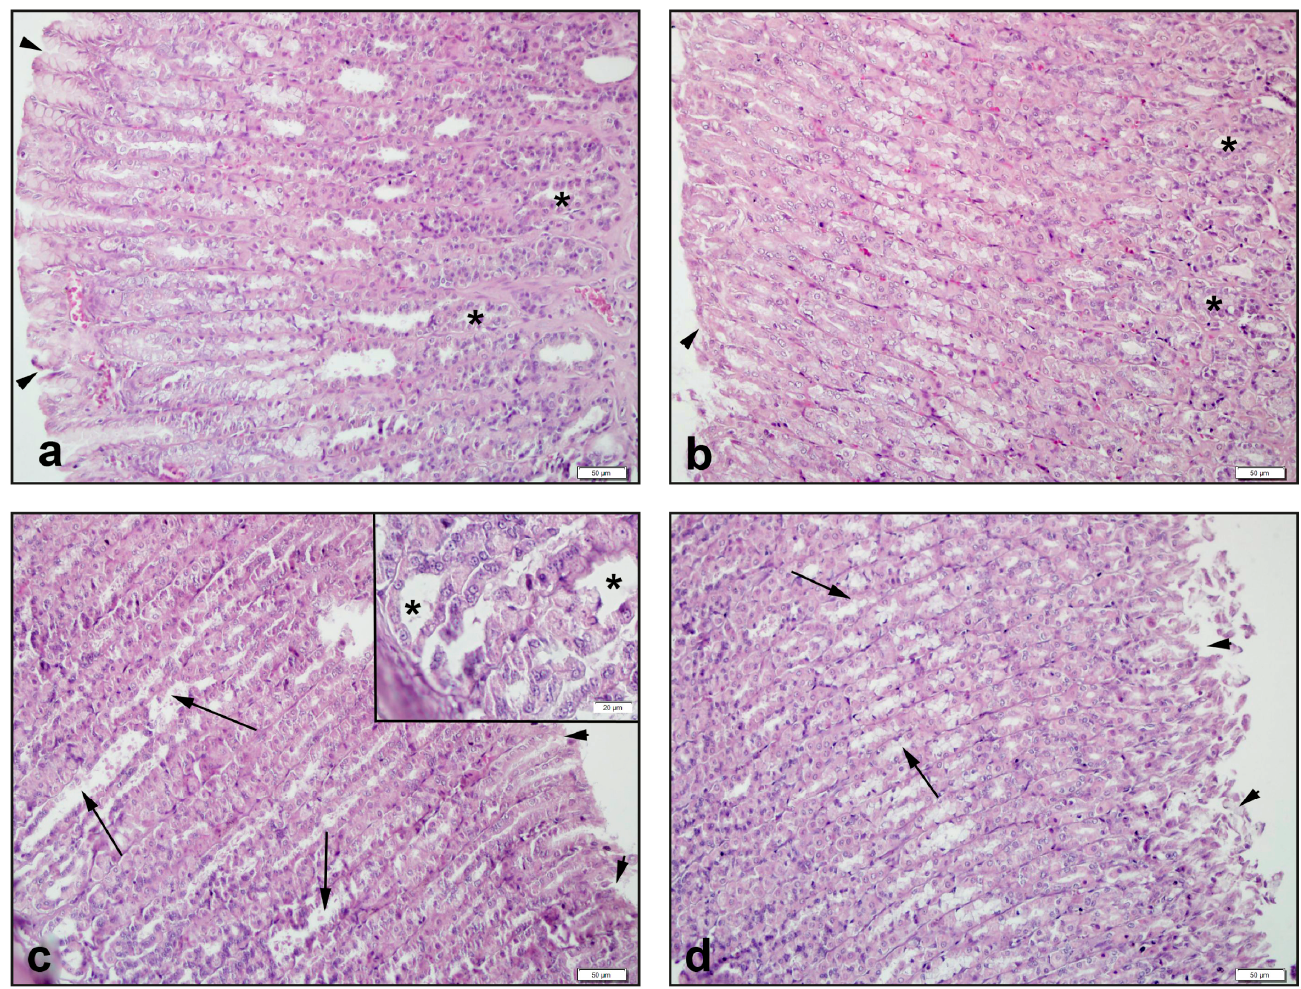
Figure 3. Histological view of stomach: ( a ) Control group of *: regular gastric glands and ‣ : regular gastric epithelium, ( b ) NAC group of *: regular gastric glands and ‣ : regular gastric epithelium, ( c ) CPT-11 group of *: irregular and enlarged gastric glands and ‣ : gastric epithelium and → : openings between gastric epithelial columns, ( d ) CPT-11+NAC group of ‣ : regression of openings between gastric epithelial columns and → : gastric epithelium. Hematoxylin & Eosin staining, 50 μ m scale bar.